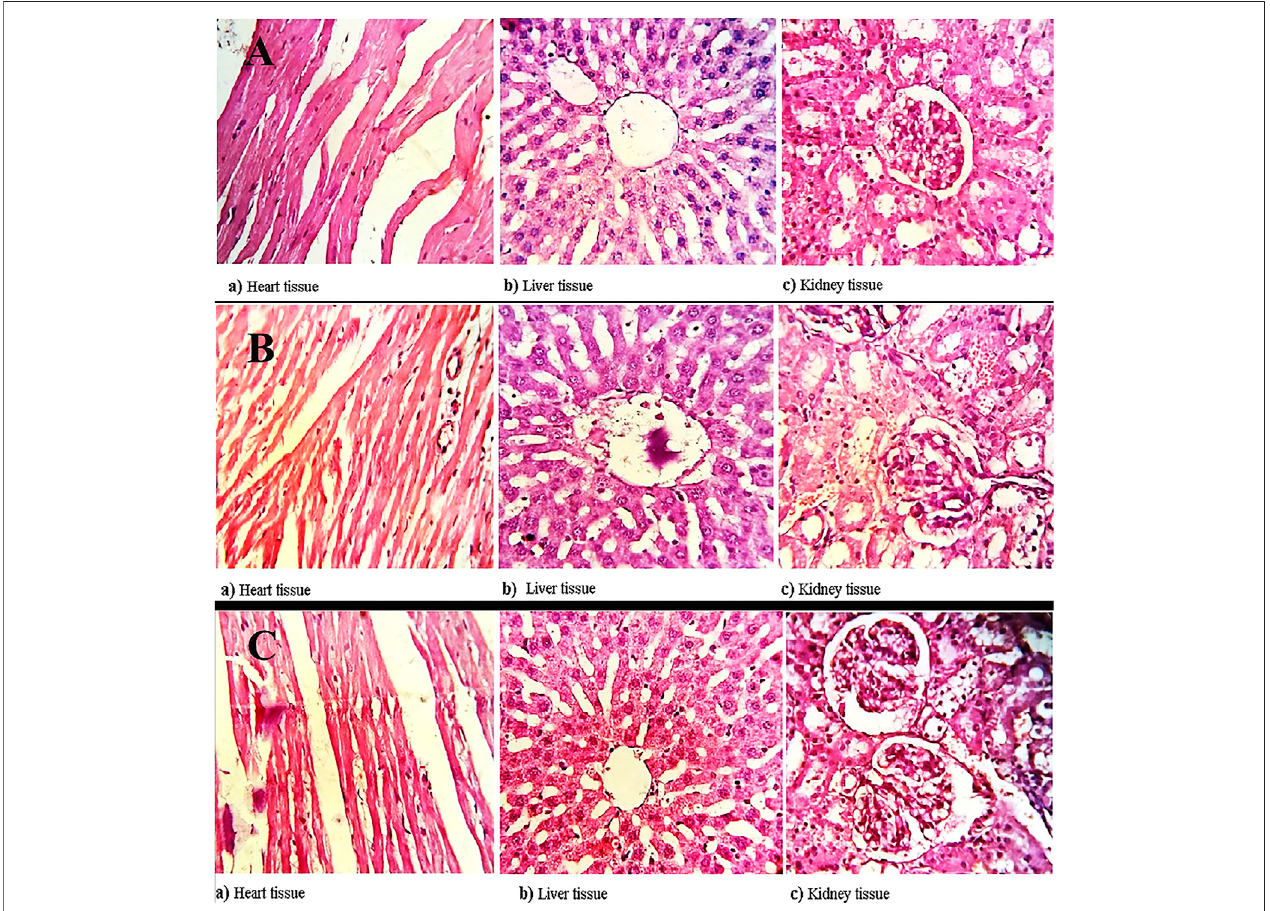
FIGURE 7 | Histopathological evaluation of (A) controlled group, (B) treated with hemicellulose and (C) thiolated hemicellulose, illustrating safety pro fi le of both modi fi ed and unmodi fi ed polymer, con fi rming that the polymers are safe to be used in in-vivo .